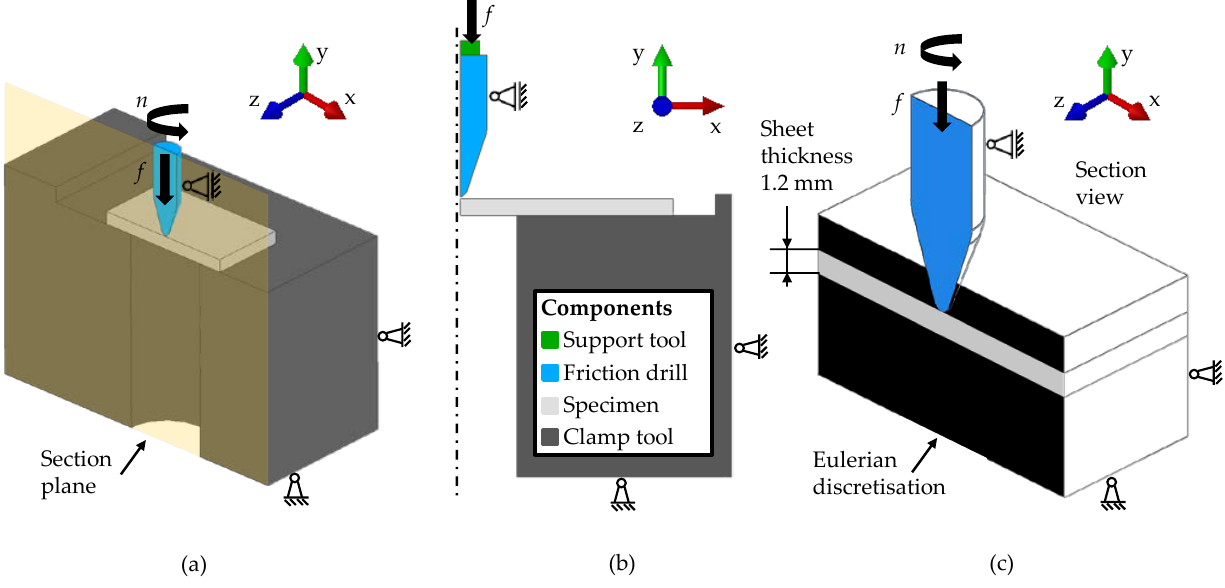
Figure 4. Geometry and boundary conditions of the numerical friction drilling models: section view of the 3D FE model ( a ); 2D FE model ( b ); and section view of the 3D FV model ( c ) with rotational speed n as well as feed rate f